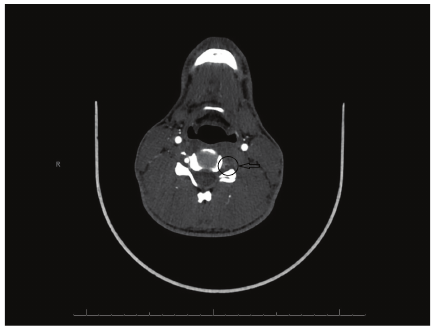
Figure 3: CT Angiogram showing hyperattenuating crescent shaped mural thickening of left vertebral artery (marked by black circle and